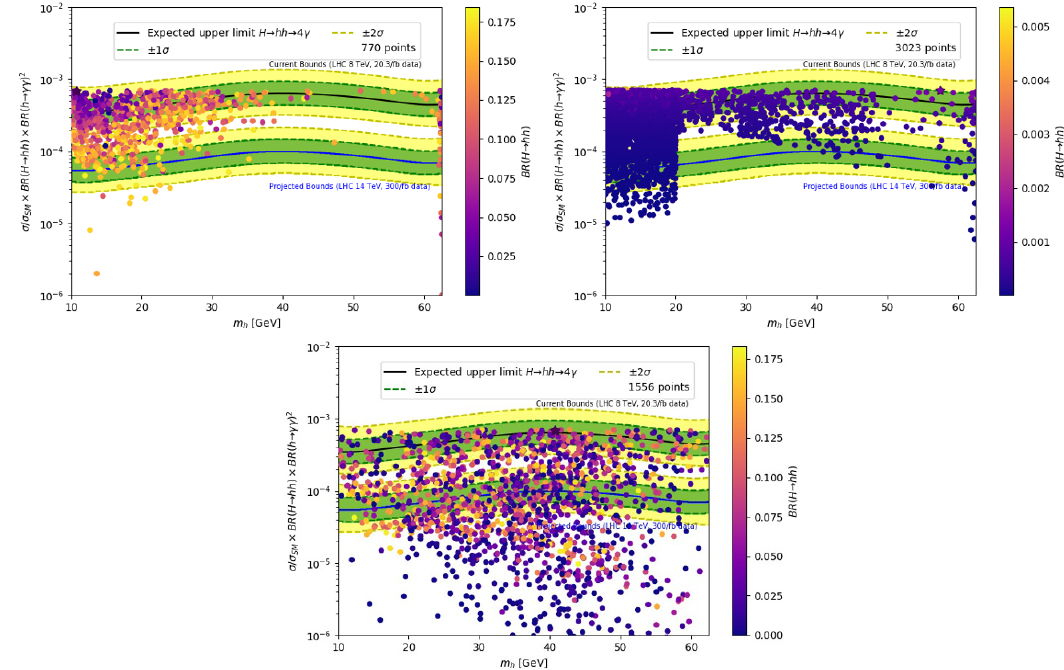
Figure 5. Upper limit at 95% CL on (cid:27) 4 (cid:13) in fb as a function of m h and the (cid:6) 1 and (cid:6) 2 uncertainty bands resulting from ATLAS searches at 8 TeV (upper band) and our projection for 14 TeV (lower band) for (top-left) scan-1, (top-right) scan-2 and (bottom) scan-3. The dots are points that are allowed by all constraints and the black stars represent the BPs given in table 2.